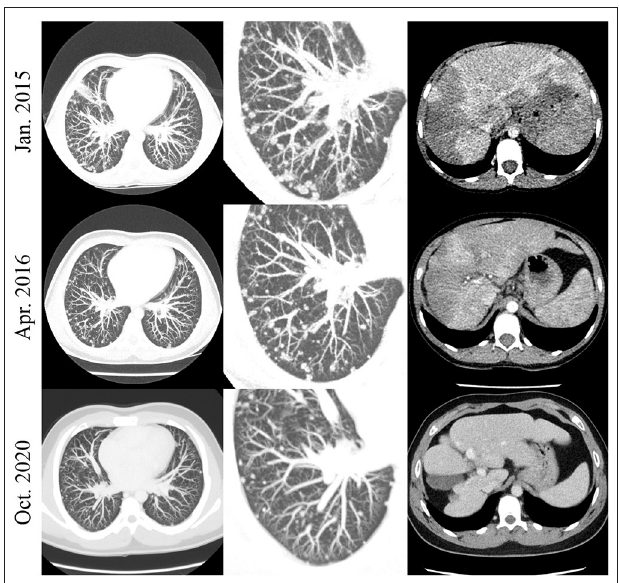
FIGURE 5 | Patient #16. Exemplary chest (left and middle row) and abdomen (right row) CT slices in patient #16. A decrease in the amount and size of the numerous nodular lung lesions is noted over time. The initially hypodense liver lesions were involuted over the course of the examinations.